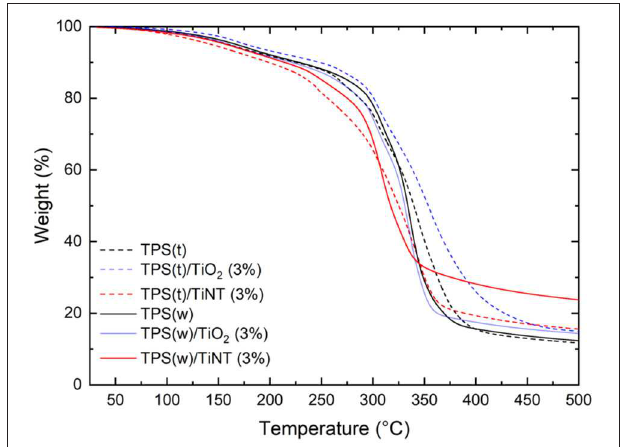
FIGURE 10 | TGA curves of TPS/TiX composites.